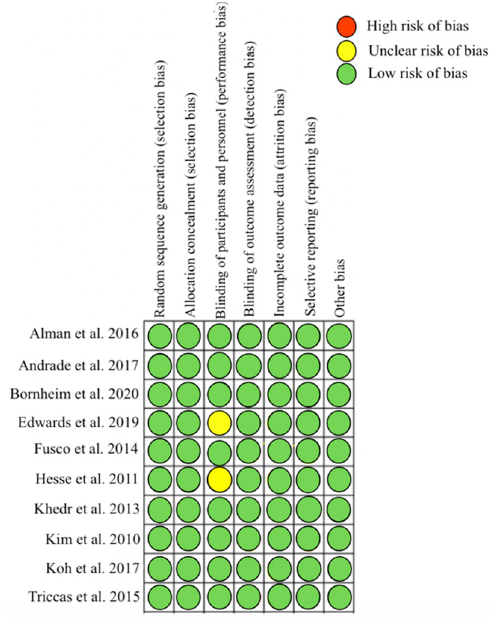
Figure 2. Risk of bias of included studies.